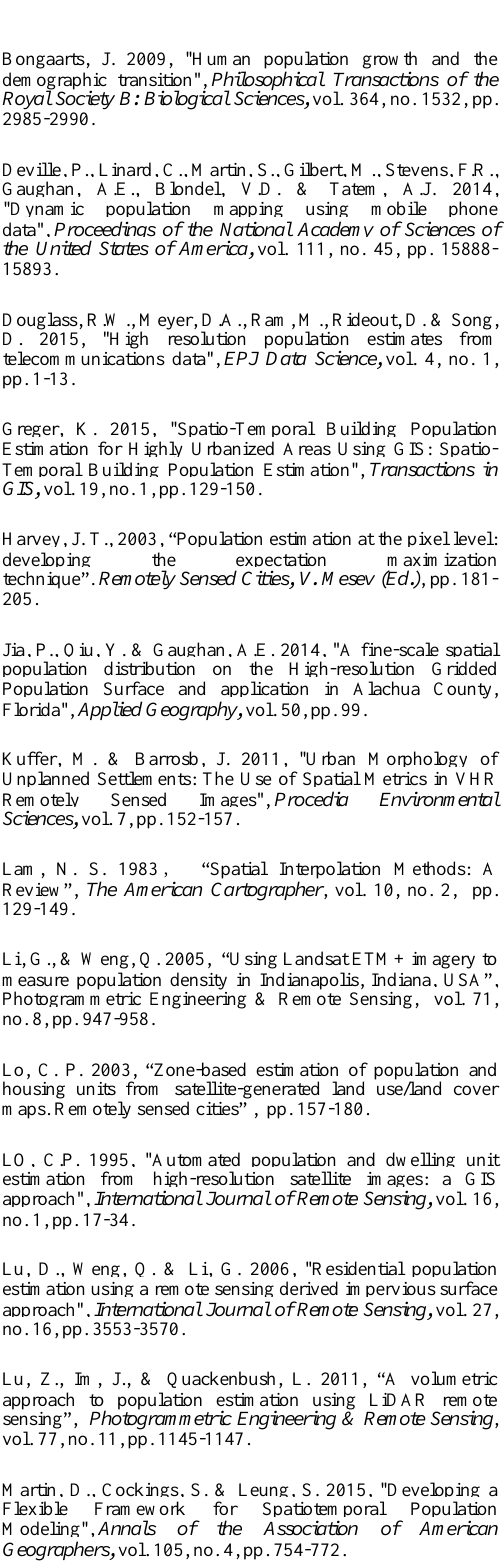
Table 1. Comparison between estimated and actual population statistics and accuracy